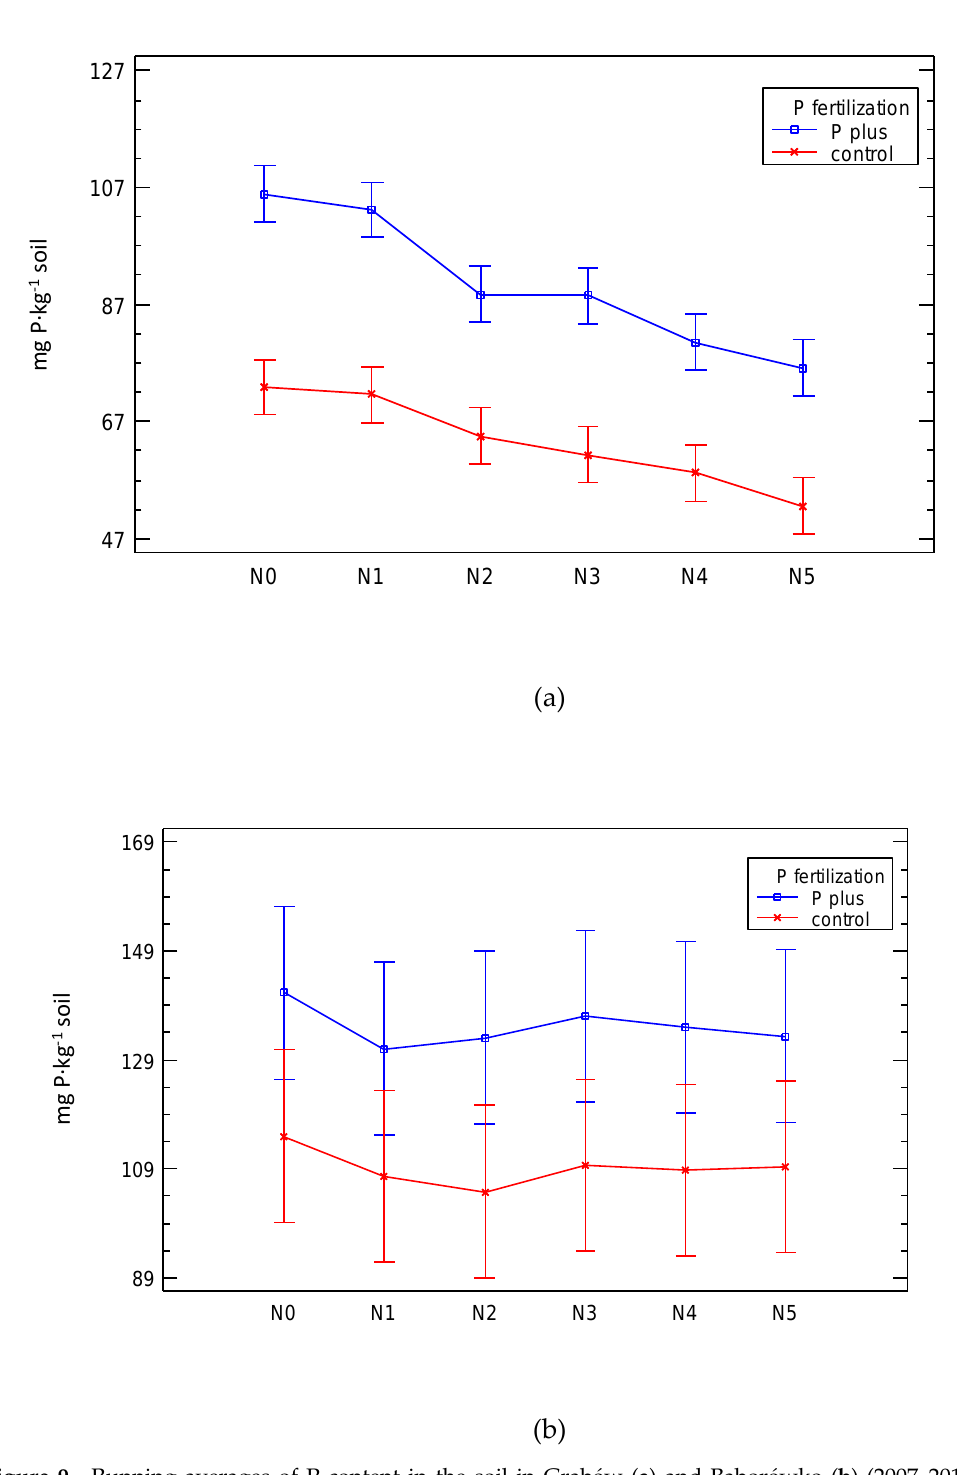
Figure 9. Running averages of P content in the soil in Grab ó w ( a ) and Babor ó wko ( b ) (2007–2018); 95% Tukey HSD intervals; n = 288 for each location (P fertilizer Grab ó w HSD 4.026, Babor ó wko HSD 13.32).